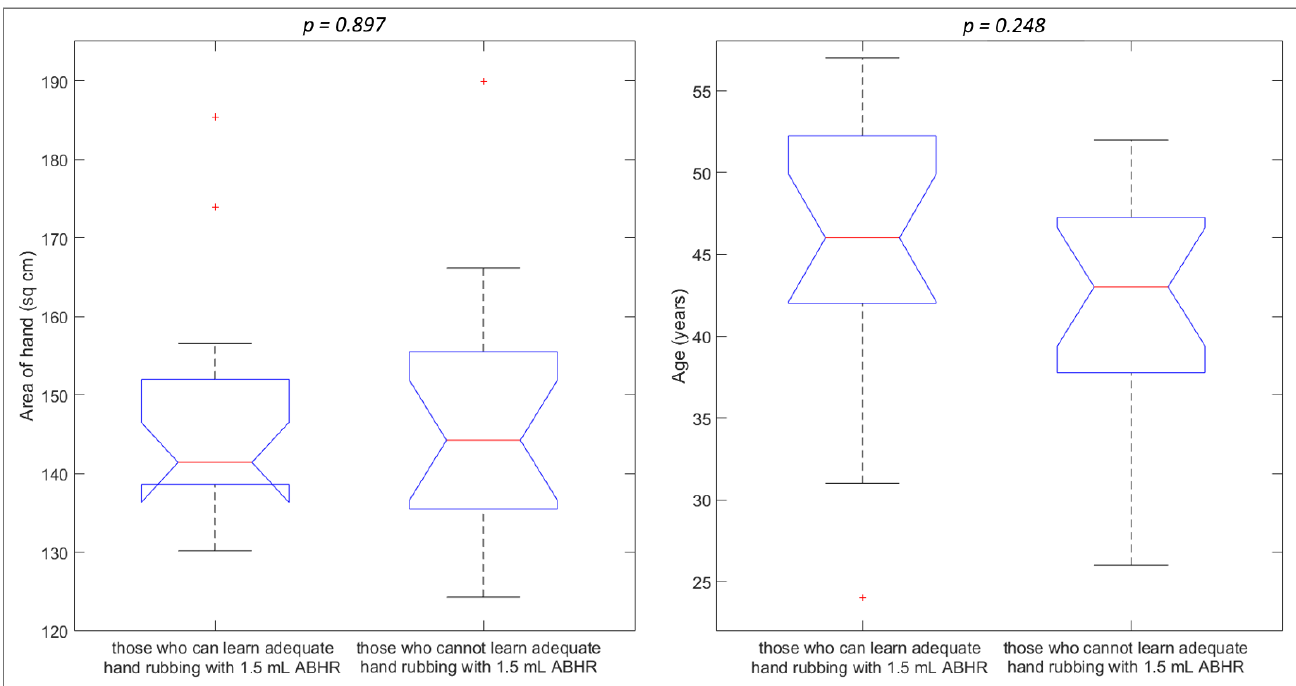
Figure 7. Relation between the ability to learn adequate hand rubbing technique and parameters like the area of hand and age of the HCW. Red crosses indicate outliers. the area of hand and age of the HCW. Red crosses indicate